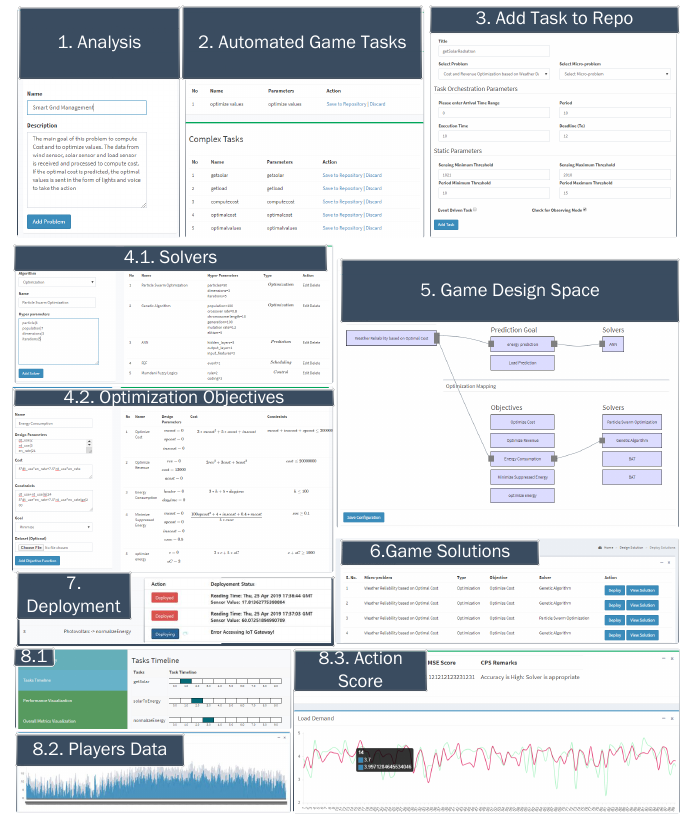
Figure 7. Administrative interface of the proposed